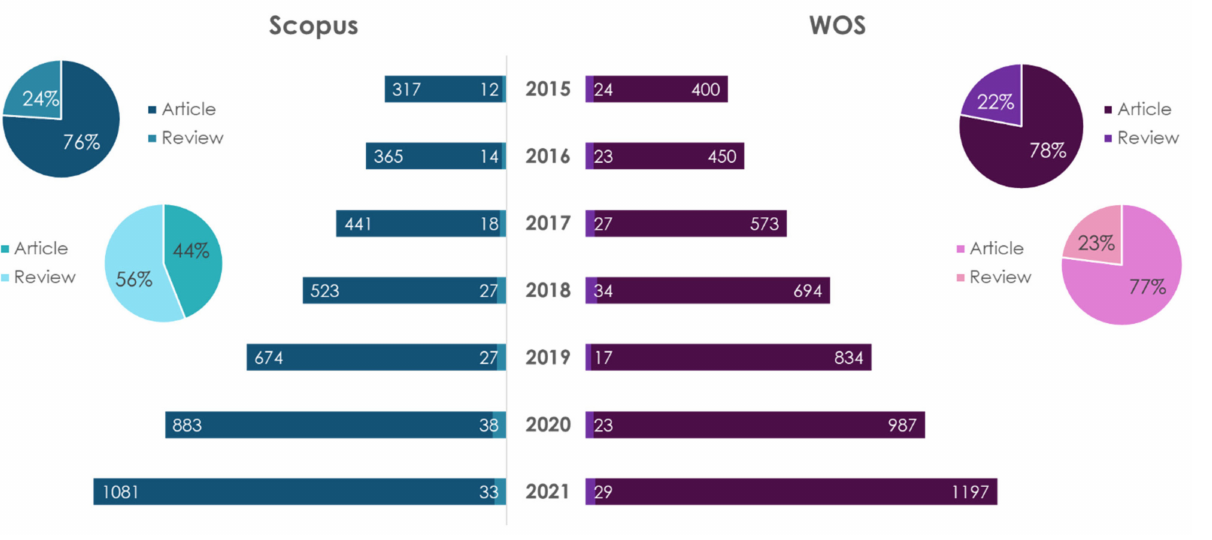
Figure 12. Statistical results of the search in Scopus/WOS databases by the keywords “Mediterranean diet” (dark color) and «Mediterranean diet and atherosclerosis» (light